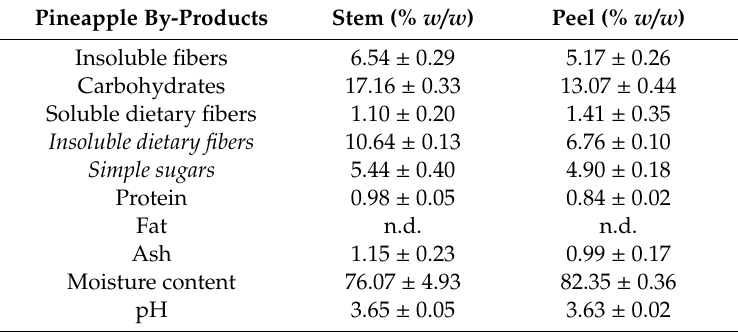
Table 1. Physicochemical composition (average ± standard deviation) of pineapple by-products (peels and stems) in fresh fruit. Results were given in dry basis.